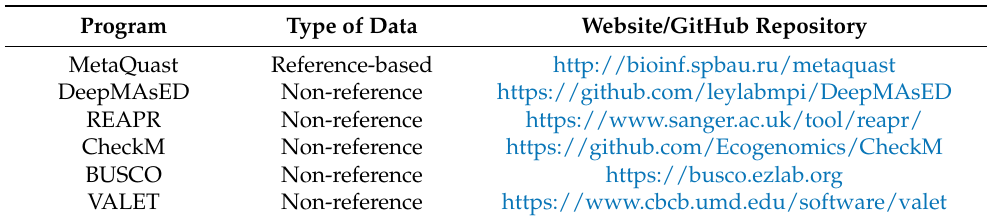
Table 5. Bioinformatic tools for quality control of metagenome assembly. All websites/GitHub Repository links were accessed on 23 December